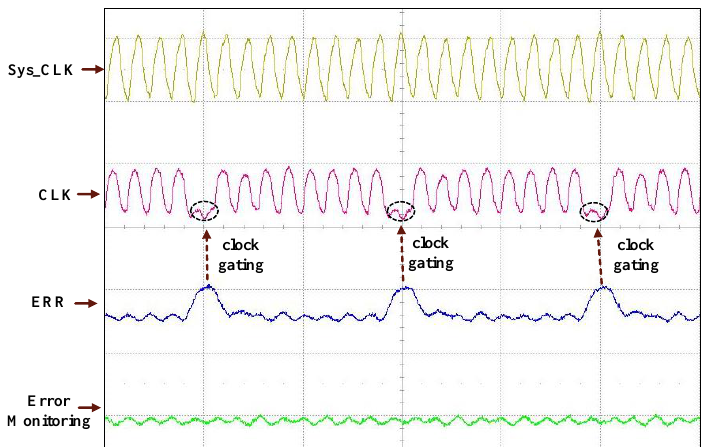
Figure 9. Measured operational waveforms of the proposed EDACFF design at 1.2 V and 90 MHz (POFF).